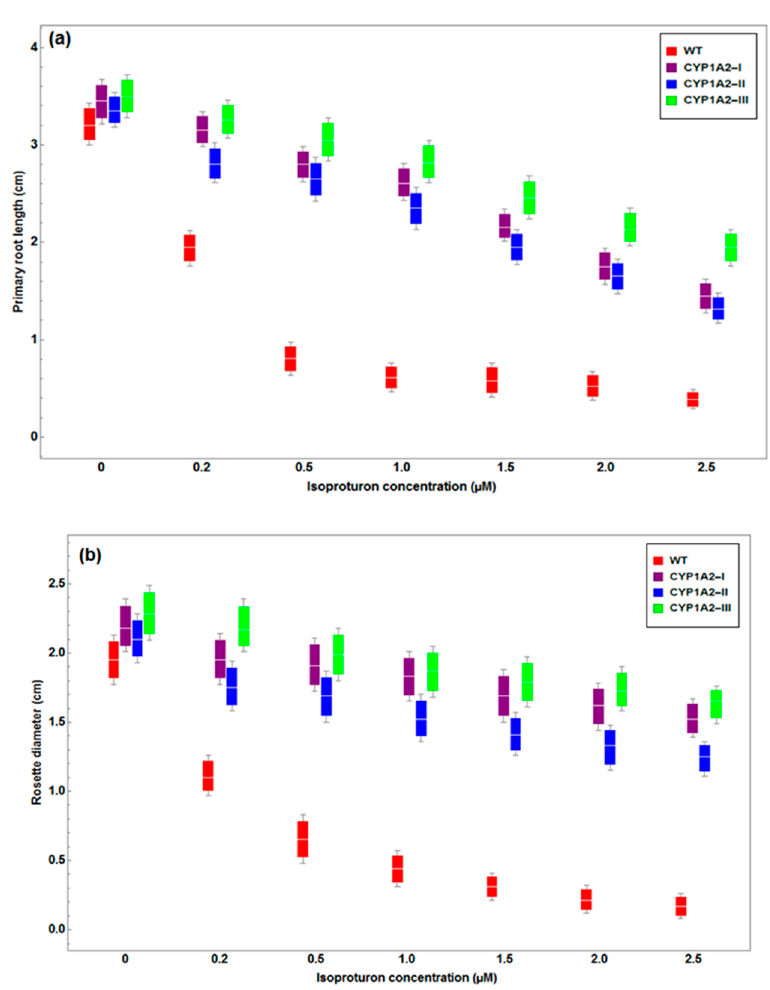
Figure 1. Effect of isoproturon on the primary root length ( a ) and rosette diameter ( b ) of wild type and CYP1A2 transgenic A. thaliana plants grown on Murachige and Skoog agar plates (MS) medium ( p < 0.05).